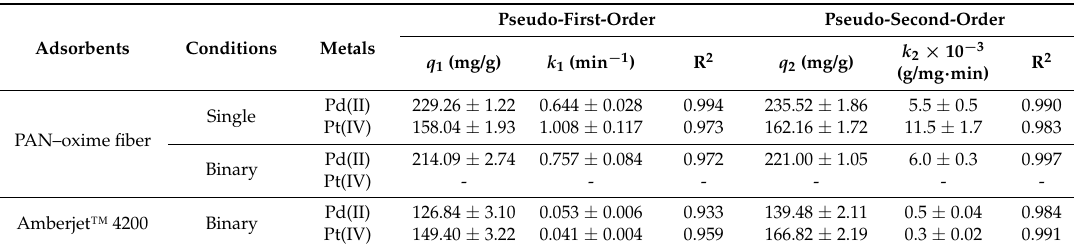
Figure 6. Adsorption kinetics of PAN–oxime fiber in single ‐ metal system ( a ) and binary metal system ( b ); and of Amberjet™ 4200 in binary metal system ( c ). Standard errors are less than 5%. Table 2. Kinetic parameters of the pseudo ‐ first ‐ order and pseudo ‐ second ‐ order models.